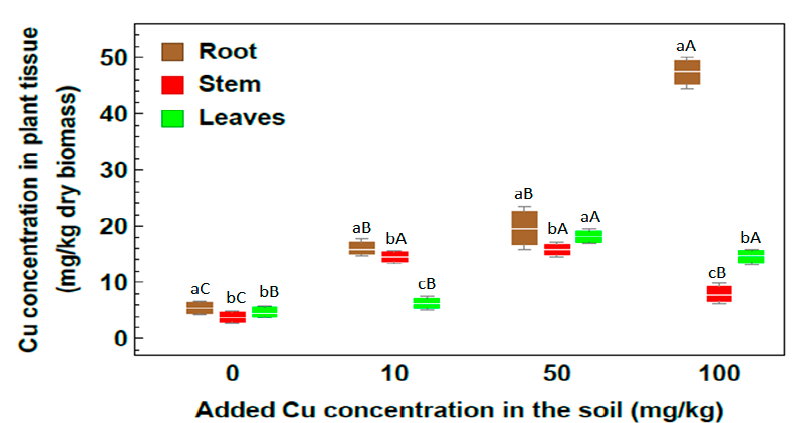
Figure 5. Concentration of Cu in plant organs of Rhazya stricta grown in soil treated with 10, 50 and 100 mg Cu/kg soil in an open greenhouse. Different lowercase letters indicate significant differences between plant parts for each soil metal concentration, and different capital letters indicate a significant difference between soil metal concentrations for each plant part ( p < 0.05).